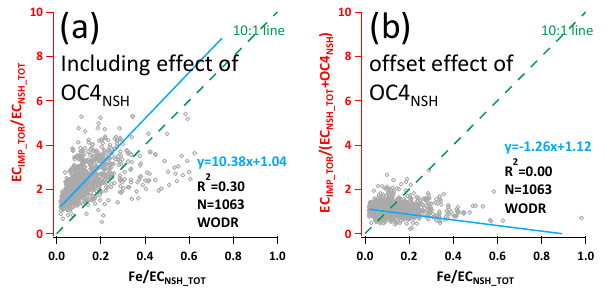
Figure 6. EC IMP_TOR -to-EC NSH_TOT discrepancy de- pendency on Fe / EC NSH_TOT ratio (metal oxide effect). (a) EC IMP_TOR / EC NSH_TOT vs. Fe / EC NSH_TOT ratio–ratio plot. (b) EC IMP_TOR / (EC NSH_TOT + OC4 NSH ) vs. Fe / EC NSH_TOT ratio–ratio